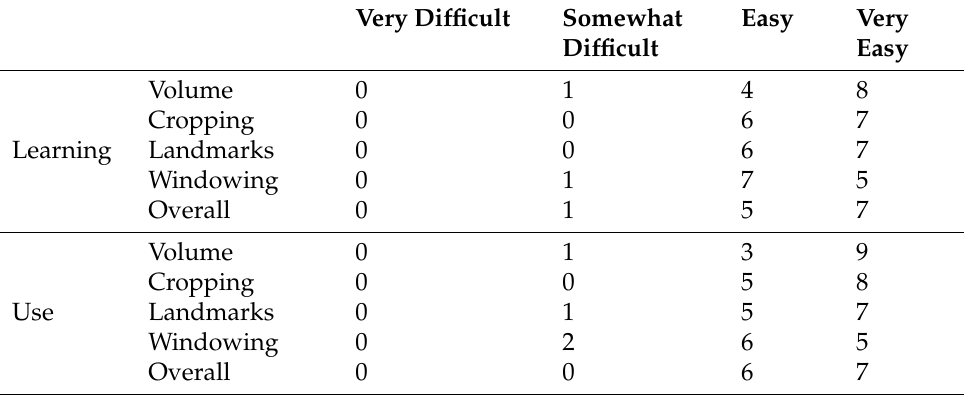
Table 2. User assessment of essential interactions of the VR system in terms of ease of learning and ease of use. All interactions were considered easy or very easy by the majority of participants, with none finding them very